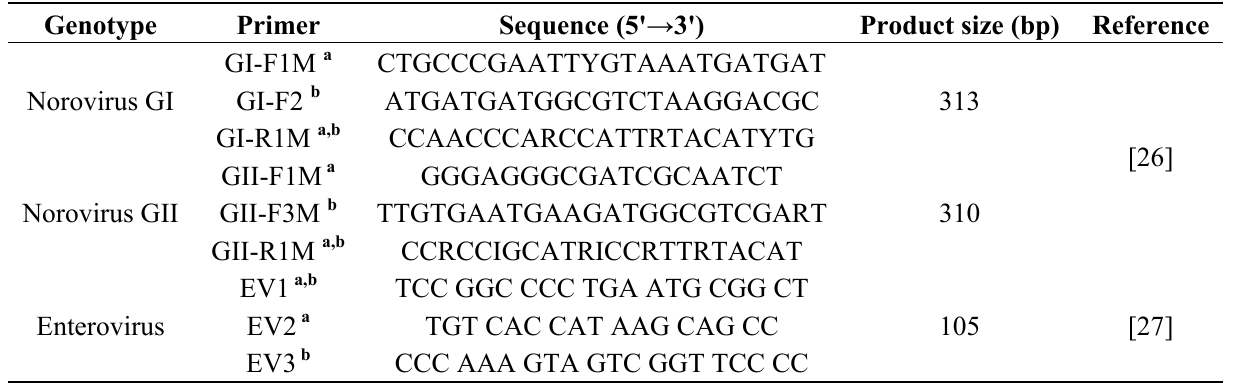
Table 1. Primer sets for detection of viruses by